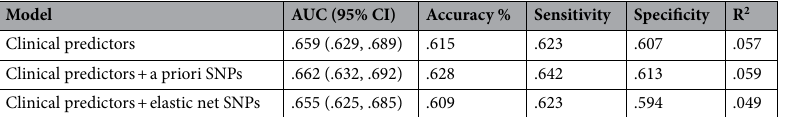
Table 2. Model performance for baseline features predicting treatment outcome. Clinical predictors model includes sociodemographic and pre-treatment symptom variables only. The model in the second row adds SNPs selected a priori based on work by 10 to the clinical predictors model. The model in the third row adds the SNPs identified by the elastic net feature selection to the clinical predictors model. For threshold-dependent metrics (accuracy, sensitivity, specificity), a probability threshold of 0.5 was used for classification.